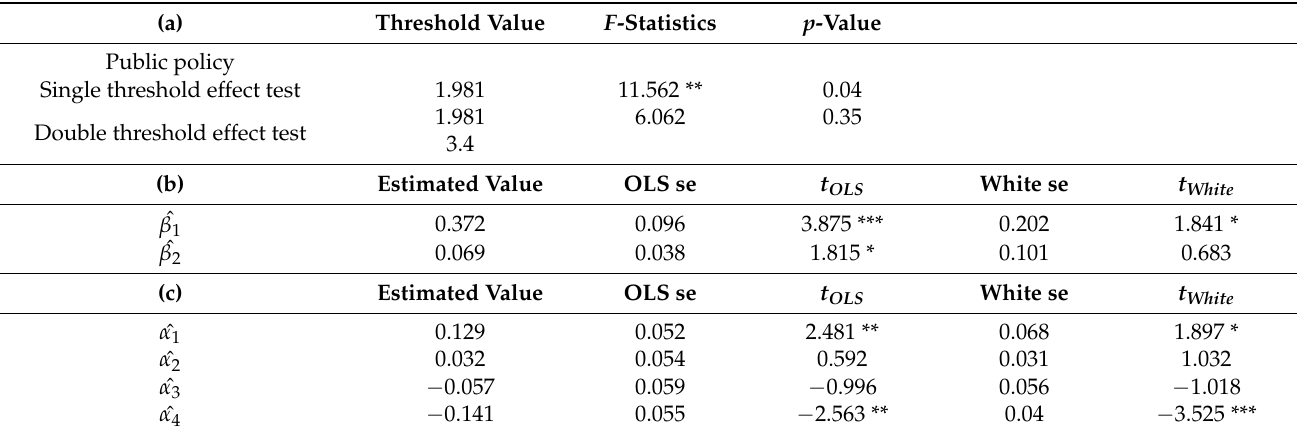
Table 4. ( a ). Tests for threshold effects between public policy and EA in EU countries. ( b ). Estimated coefficients of public policy. ( c ). Estimated coefficients of the control variables.